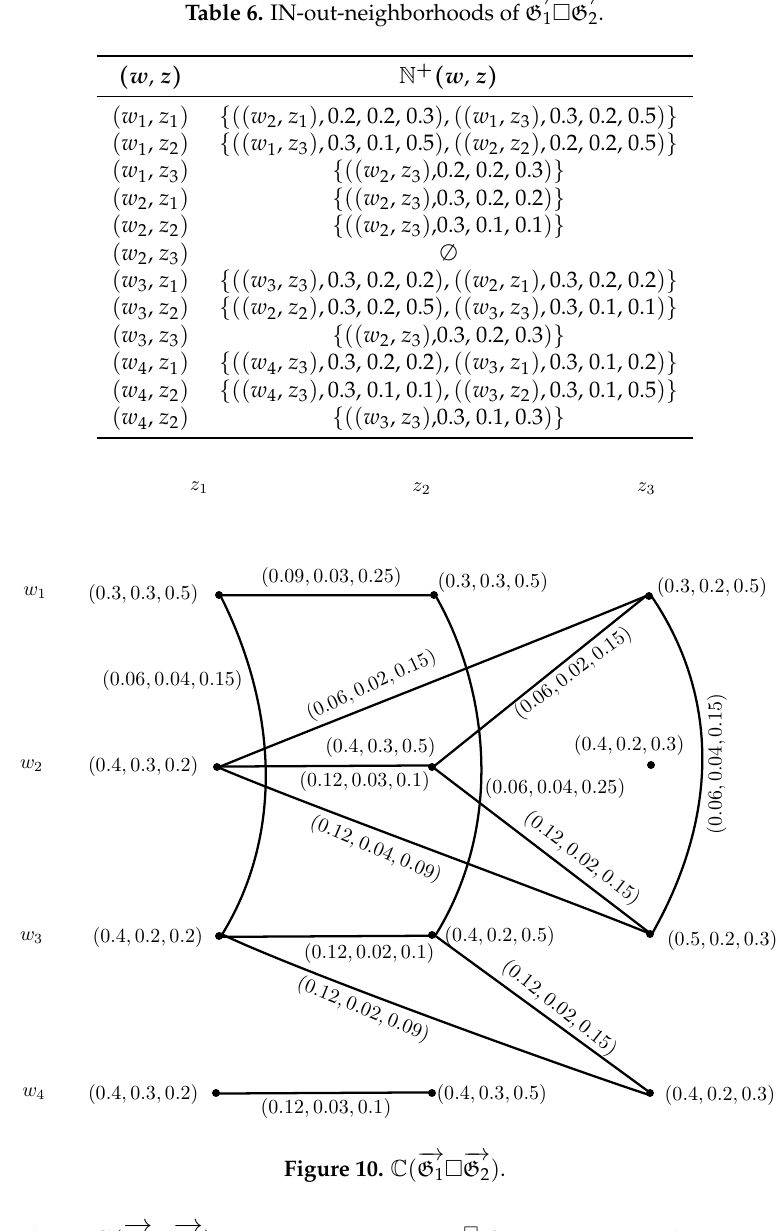
Figure 10. C ( −→ G 1 (cid:3) −→ G 2 )